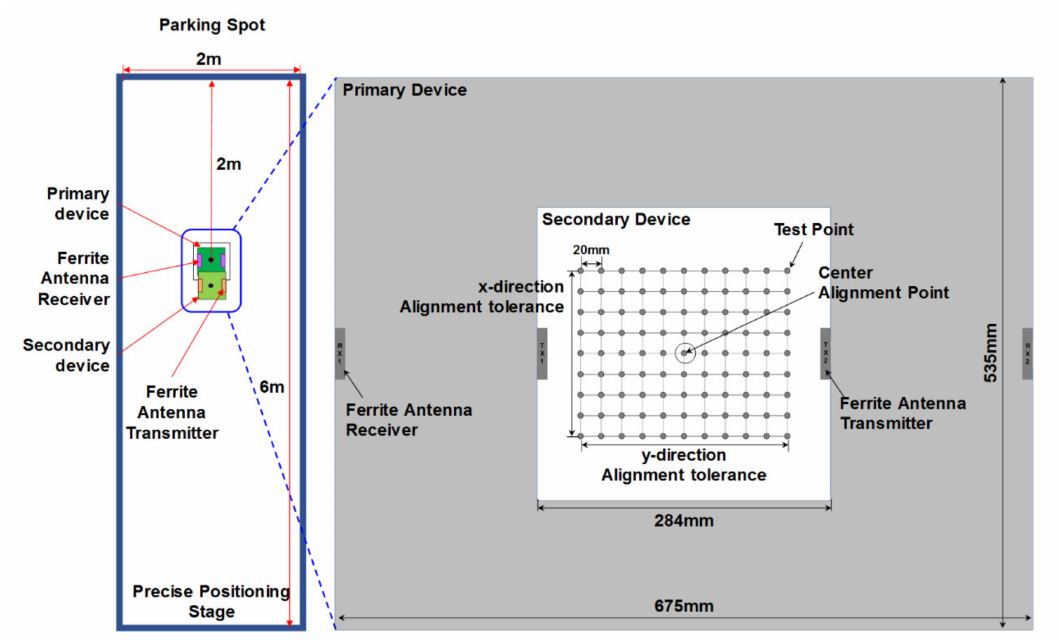
Figure 15. Test point for checking minimum wireless power transfer e ffi ciency in precise